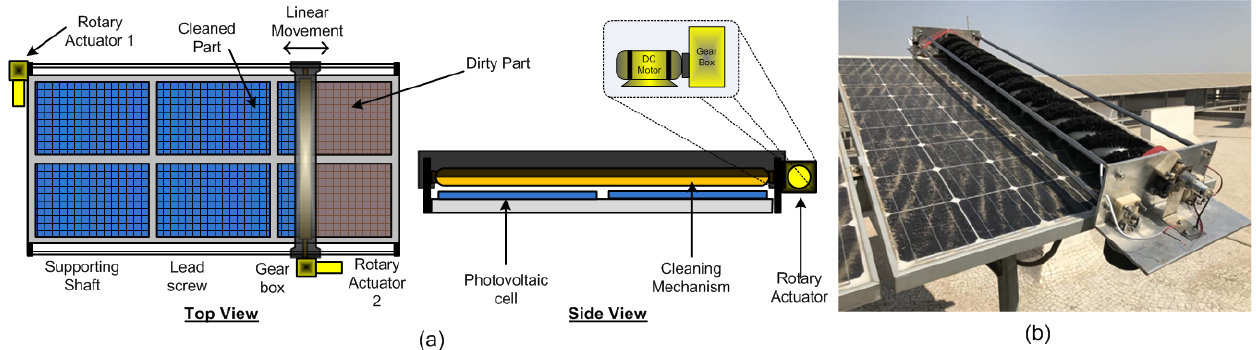
Figure 6. Actuators for solar panel cleaning: ( a ) Hybrid actuators functioning in solar cleaning application, ( b ) prototype model of wheeled automatic cleaning robot